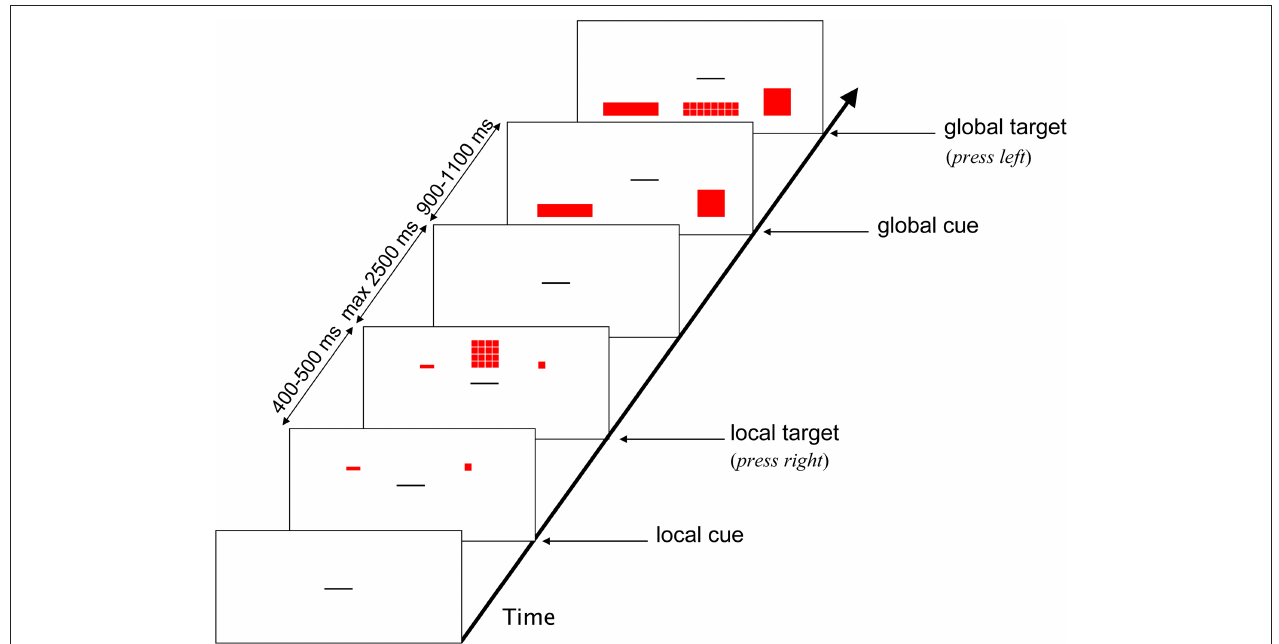
Figure 1 | Sequence of events for a local and a global target trial.